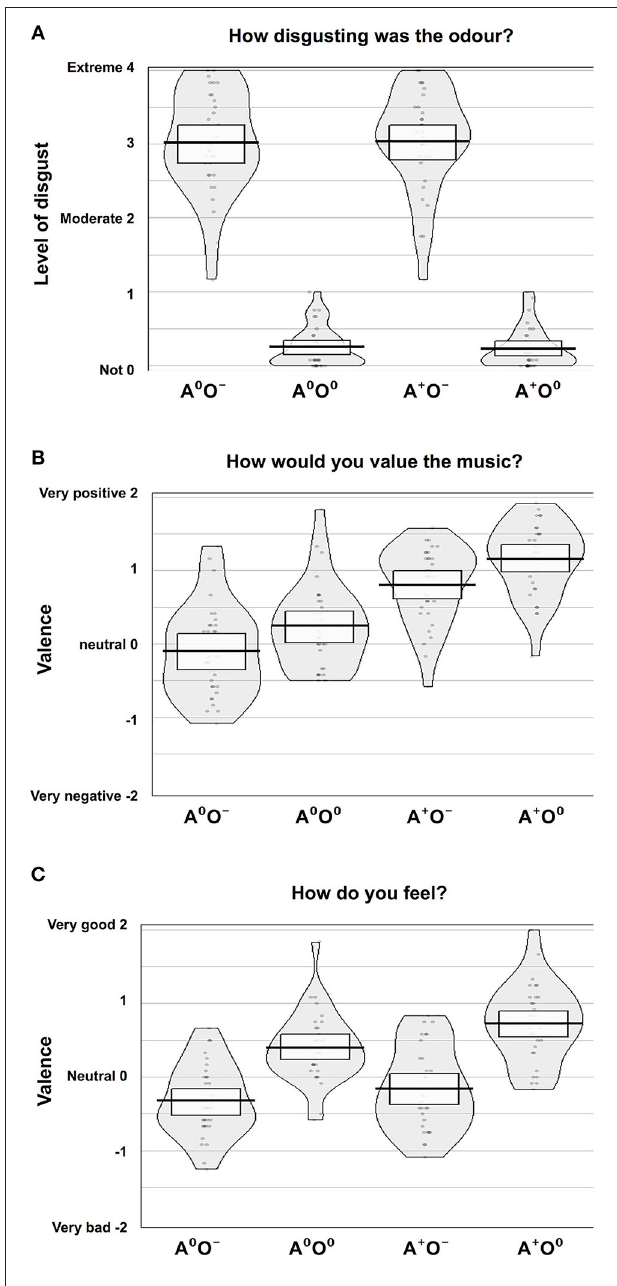
FIGURE 2 | Subjective rating results. Ratings of (A) disgust level, (B) valence of music, and (C) emotional state according to the four conditions, auditory